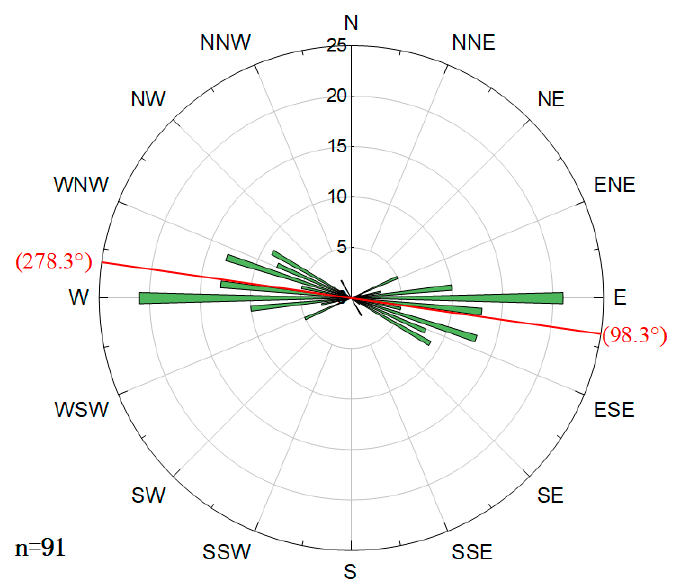
Figure 4. DDT azimuths in image pairs 3 and 10 (Ls = 159.8 °– 162.5°, n = 91). The red line is the direction of the weighted average, and the red number is the weighted average.